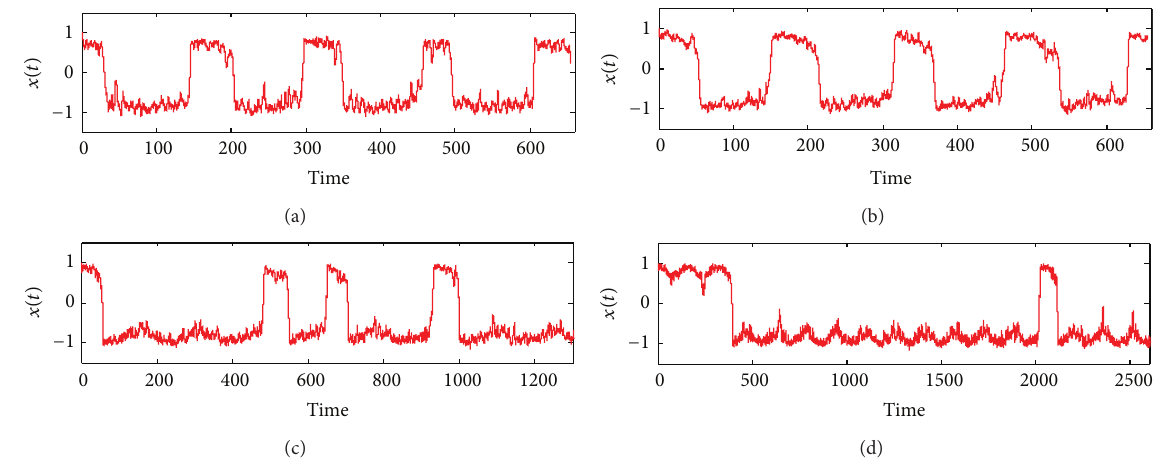
Figure 1: The system responses of the underdamped and overdamped bistable system (a) 𝜂 = 0.2 , (b) 𝜂 = 0.6 , (c) 𝜂 = 1.0 , and (d) 𝜂 = 1.4 .